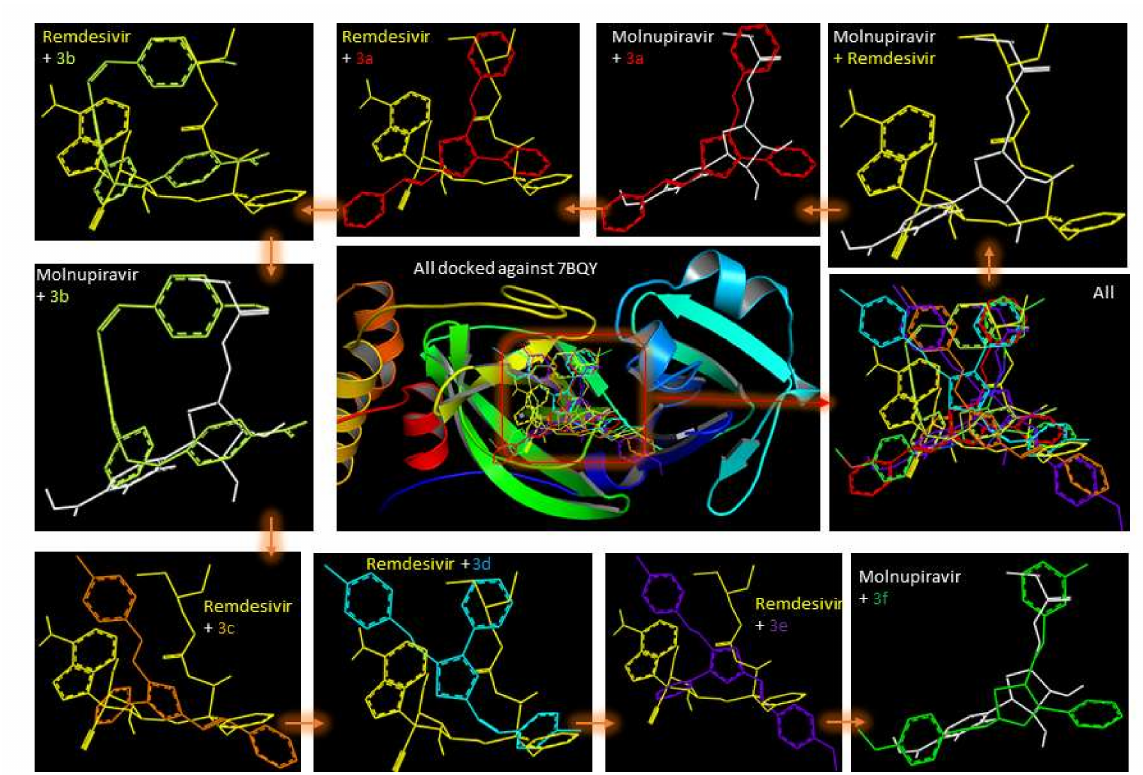
Figure 2. The superpositions of compounds 3a–f and the approved drugs docked together into the binding pocket of 7BQY. Ligands, drugs, and labels are